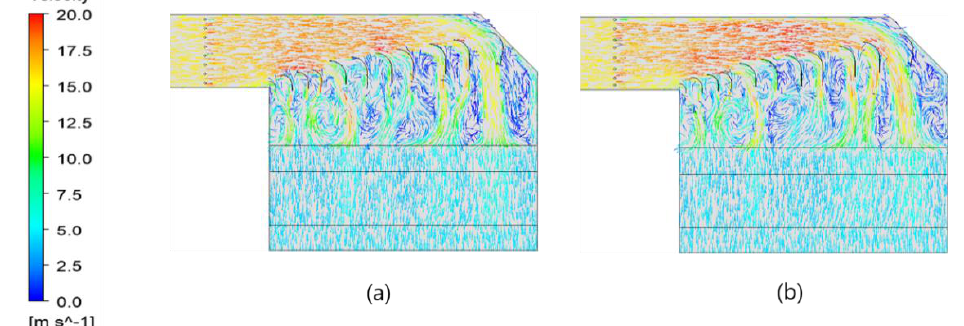
Figure 11. Distribution of NH 3 /NO around the flow passage for the parabolic profile. ( a ) Constant injection; ( b ) adjusted injection; ( c ) optimized injection.